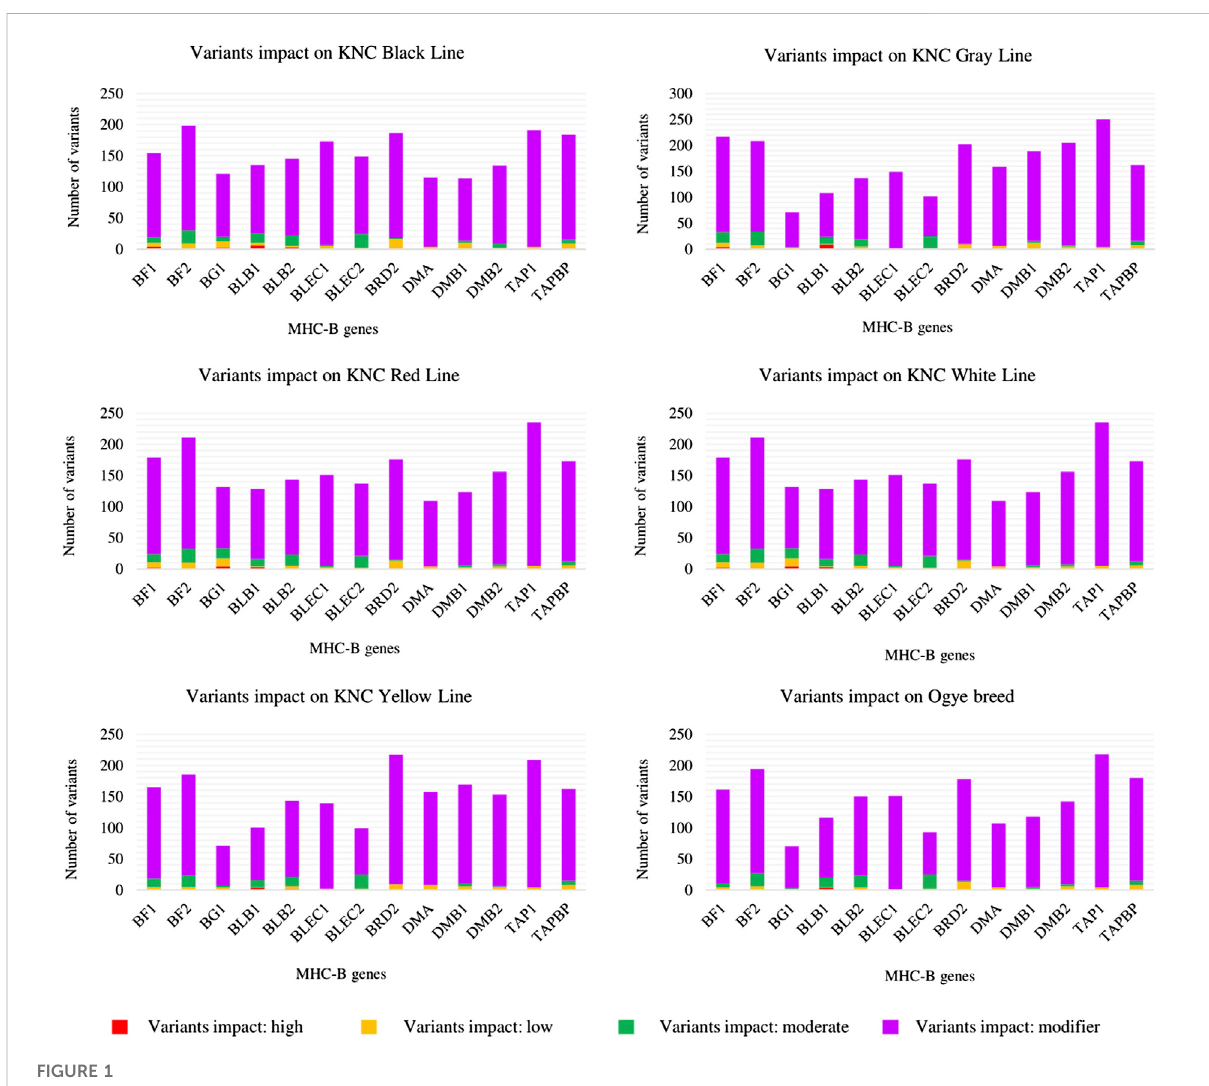
FIGURE 1 Impact of the variants on MHC- B genes for six KNC